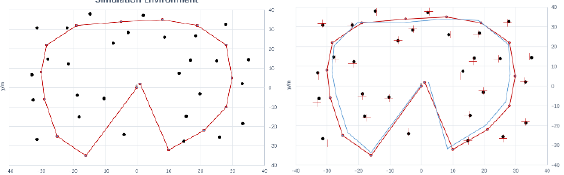
Figure 1: Simulation Environment Figure 2: Estimate result of EKF